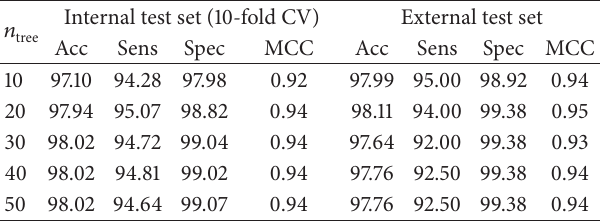
Figure 3: Prevalence of metabolic syndrome components among the subjects using NCEP ATP III.